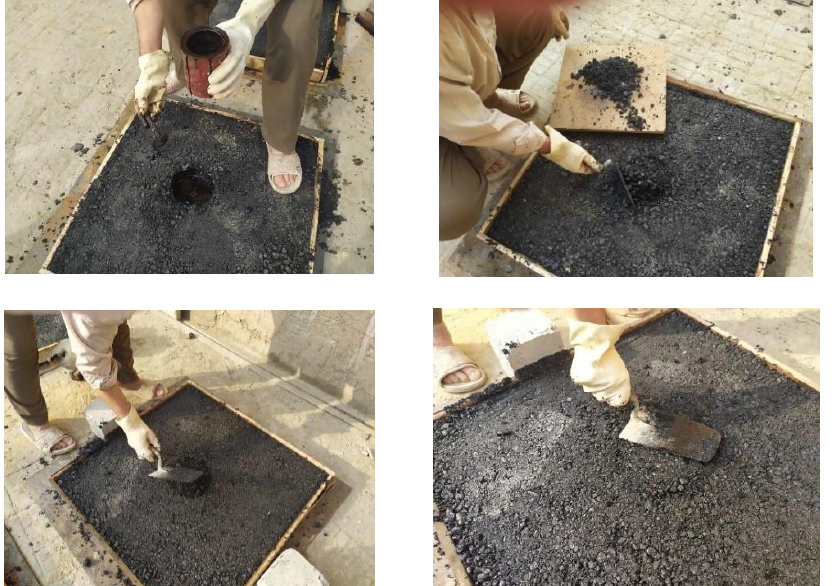
Figure 2. Steps of patching circular potholes.